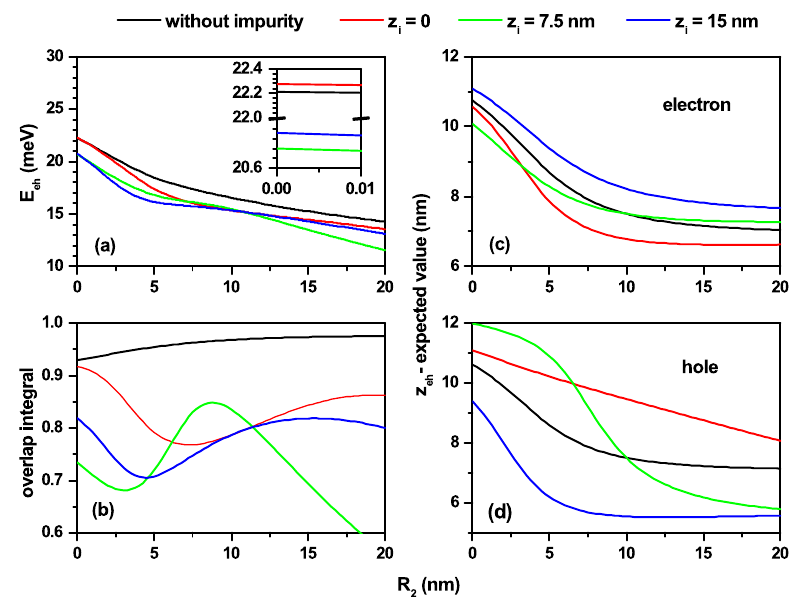
Figure 5. Characterization of the heavy hole exciton states in a truncated conical-shaped GaAs- Al 0.3 Ga 0.7 As quantum dot as a function of the R 2 -lower structure radius. ( a ) Electron–hole Coulomb energy, ( b ) overlap integral, and ( c , d ) the z -average position of the carriers; electron ( c ) and heavy hole ( d ). According to the color code, calculations are without and with a shallow donor impurity, localized at three positions along the z -axis. The results are for R 1 = 10nm, h = 15nm, and B = 0. The inset in Figure 5a shows in detail the situation R 2 ∼ 0 where it is evident that the four energies are different despite having two almost equal